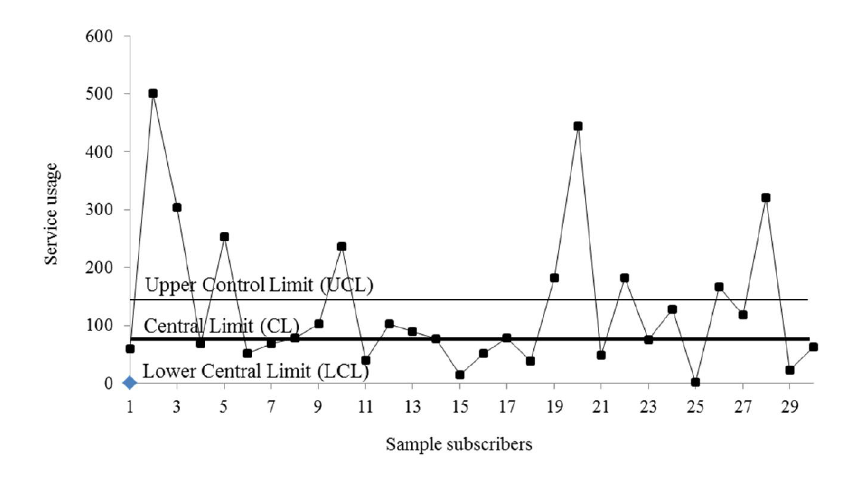
Fig. 1. The proposed control charts are simulated with latest month of subscriber usage to detect potential mismatch price